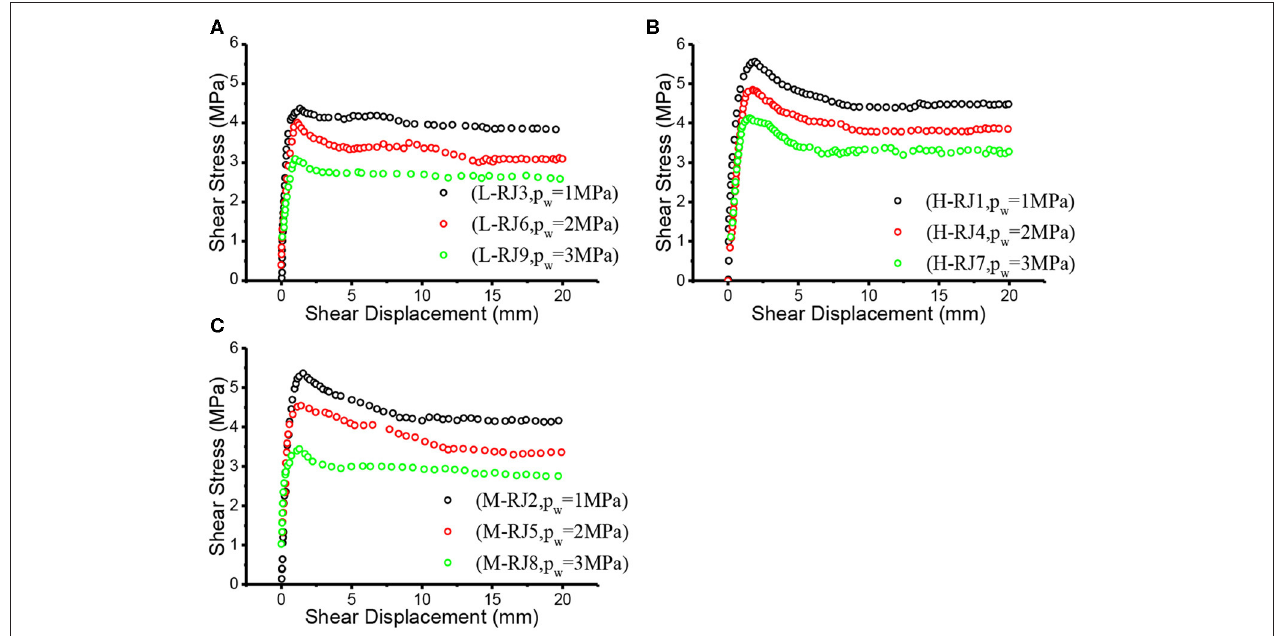
FIGURE 1 | Shear stress-displacement curves of three joint groups under normal stress of 5 MPa and three different seepage pressures. (A) L joint (B) H joint (C) M joint.